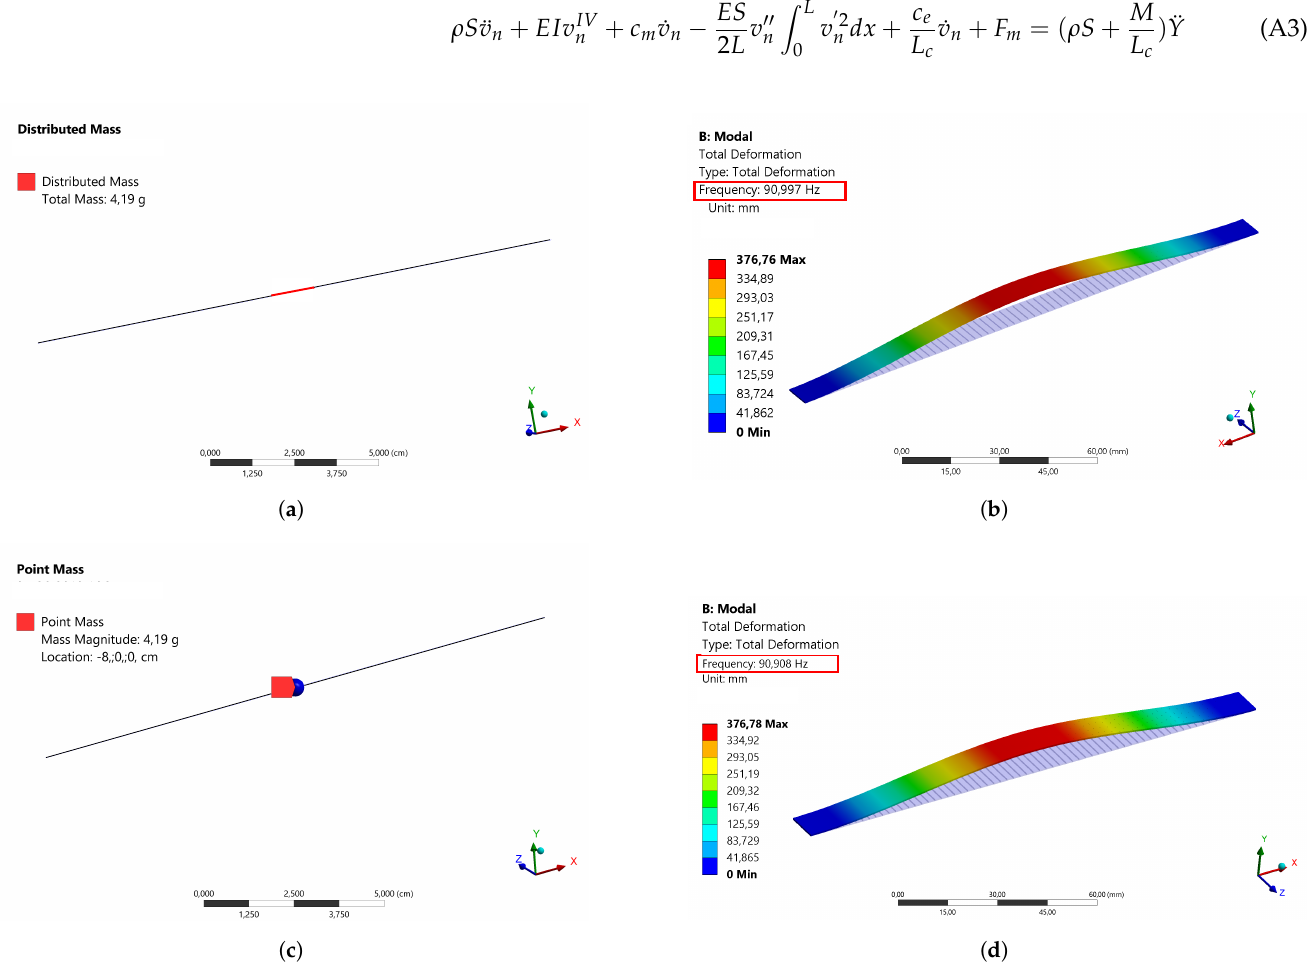
Figure A1. Distributed magnet mass: ( a ) Illustration and ( b ) Frequency and mode shape of the beam. Point magnet mass: ( c ) Illustration and ( d ) Frequency and mode shape of the